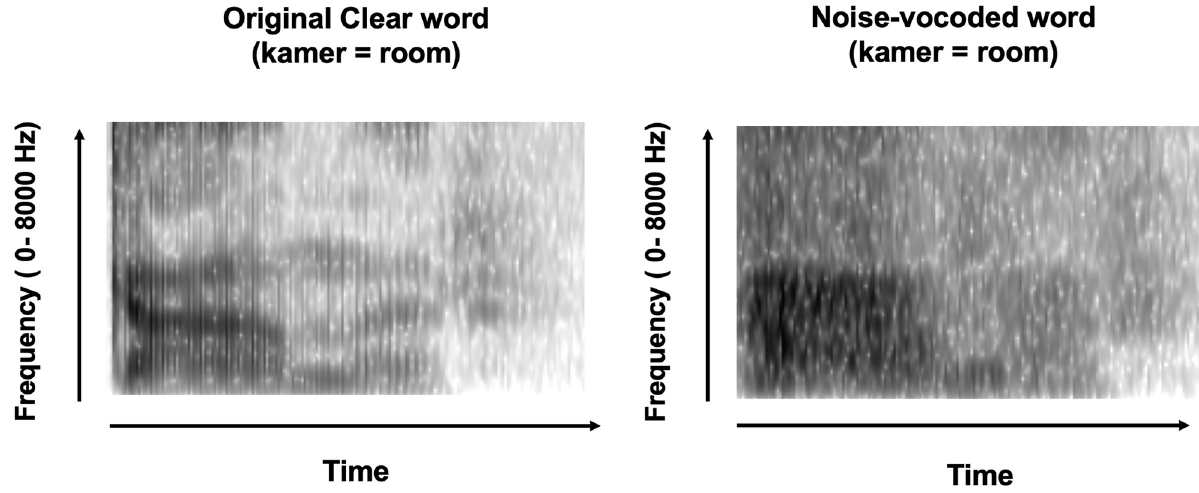
Fig 1. Example spectrograms. Original and noise-vocoded spectrogram for the item ‘kamer’.